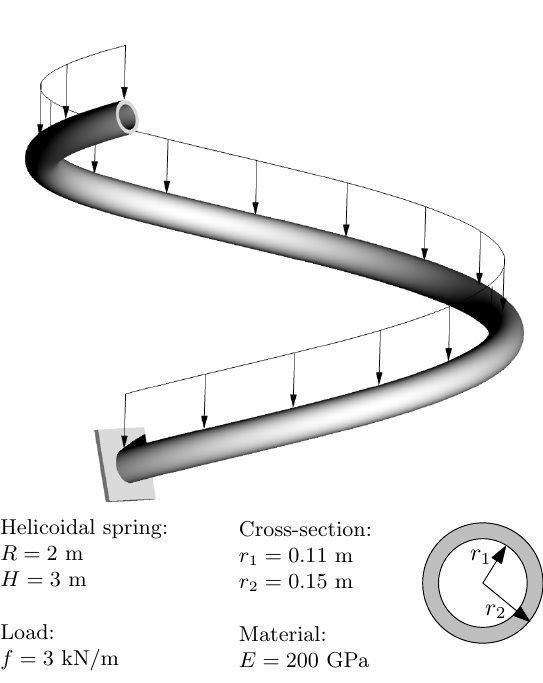
Figure 5. Helicoidal spring cantilever subjected to the constant force load and its cross-section.